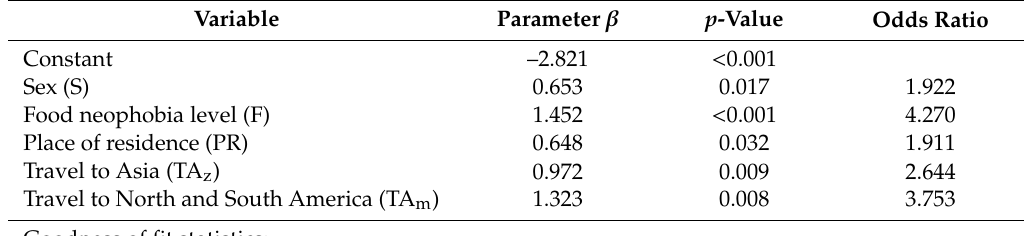
Table 5. Estimation results of the logit model of the acceptance of edible insects (IA) in the students’ diet. Variable Parameter β p -Value Odds Ratio Constant